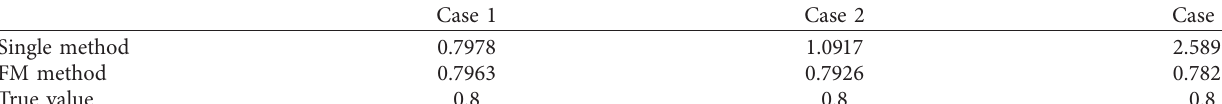
Table 2: Final result of MH sampling.